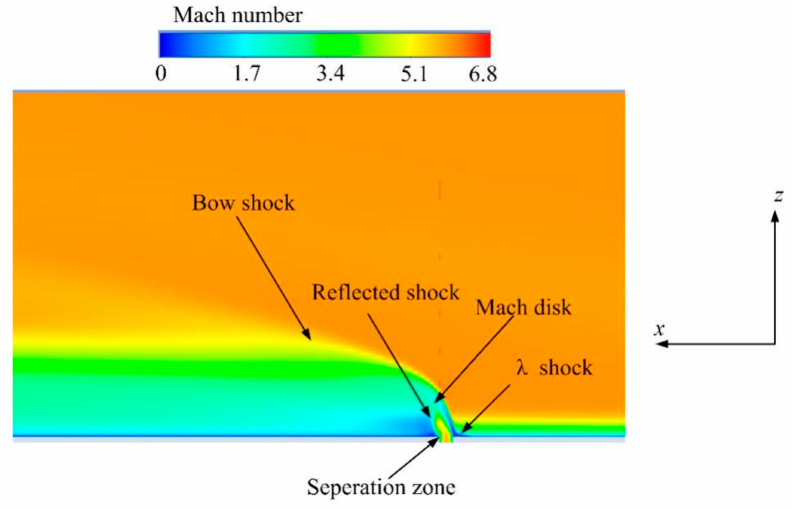
Figure 8. Diagram of the transverse jet flow field for Case a.